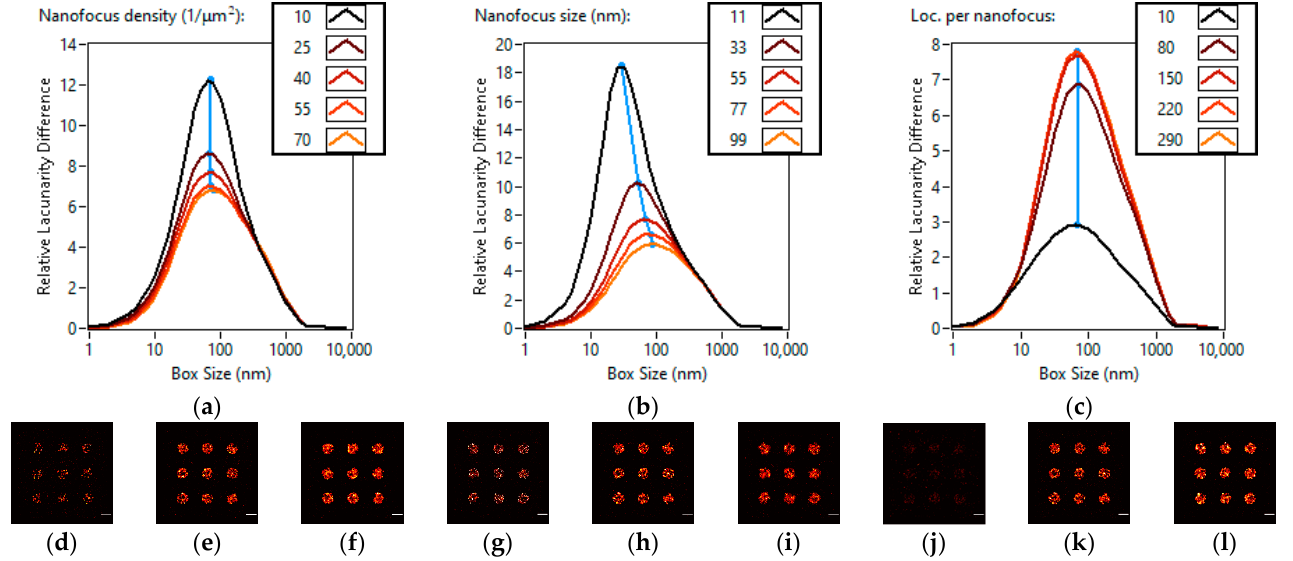
Figure 3. Effects of changing nanofocus parameters on lacunarity. Lacunarity difference curves of TestSTORM generated datasets of different nanofocus densities ( a ), nanfocus sizes ( b ), localizations per nanofocus ( c ). Three super-resolution images of the simulated data are also shown for each lacunarity difference curve. Nanofocus densities of 10/ µ m 2 ( d ), 40/ µ m 2 ( e ) and 70/ µ m 2 ( f ). Nanofocus sizes of 11 nm ( g ), 55 nm ( h ) and 99 nm ( i ). Number of localizations per nanofocus of 10 ( j ), 150 ( k ) and 290 ( l ). Scale bars are 1 µm.